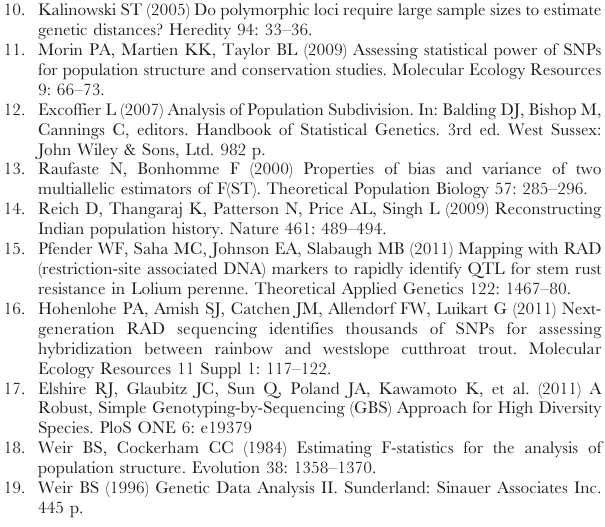
individuals was fixed at n= 4 (right middle column) and n = 20